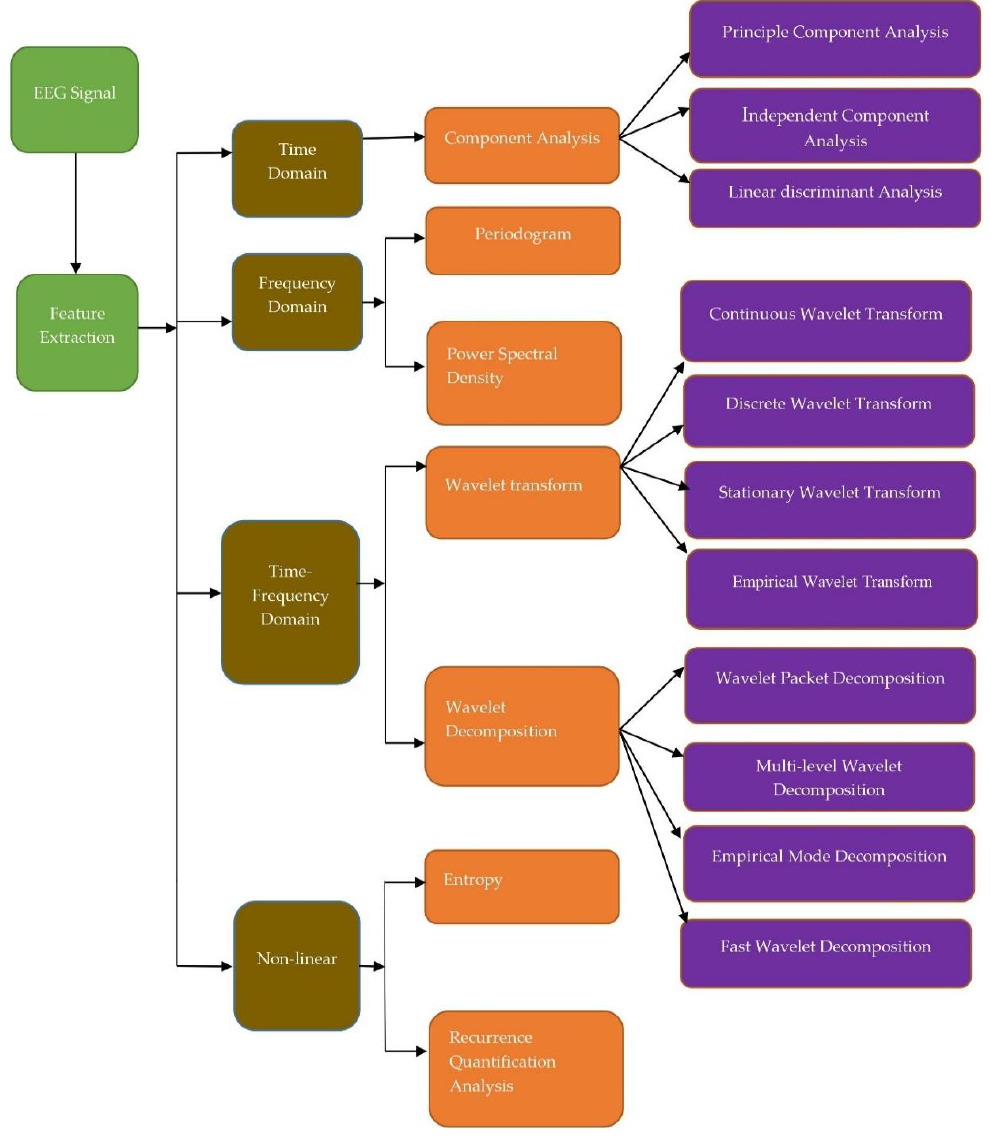
Figure 3. Methods to analyze EEG signals.